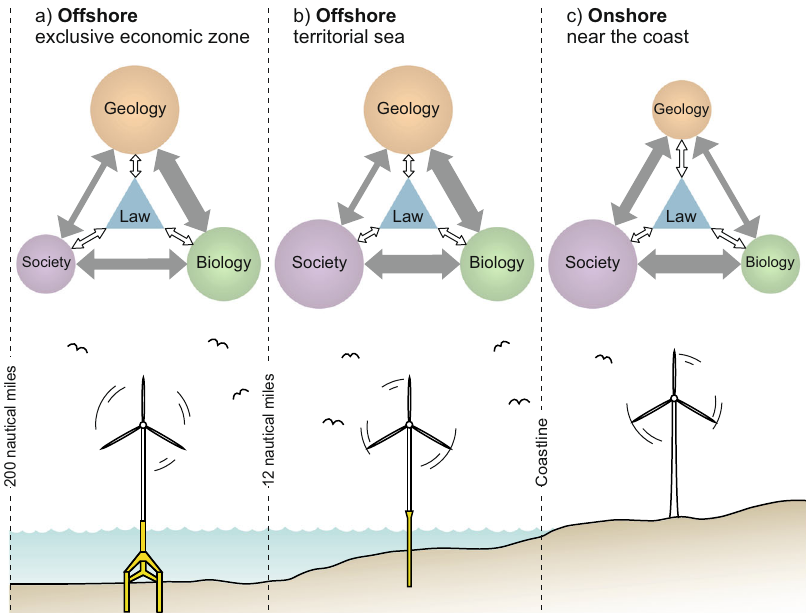
Fig. 2 Conceptual model developed by the group during phase 2. It represents the different weighting (circle size) and interactivity (arrow width) of the four disciplines in the context of wind farm construction between a offshore within the executive economic zone, b offshore within the territorial sea, and c onshore near the